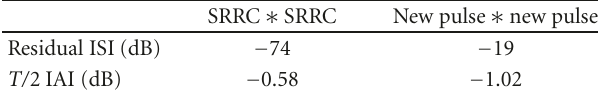
Table 2: Square root raised cosine versus new